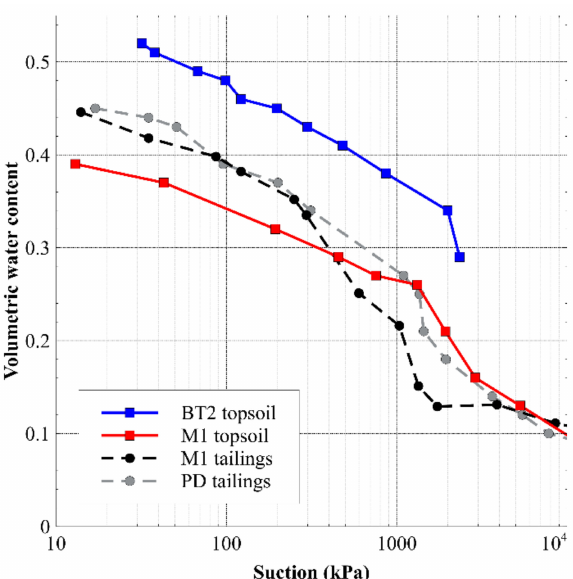
Figure 12. Drying path of the water retention curves measured for each tailings and topsoil, expressed in volumetric water content vs.